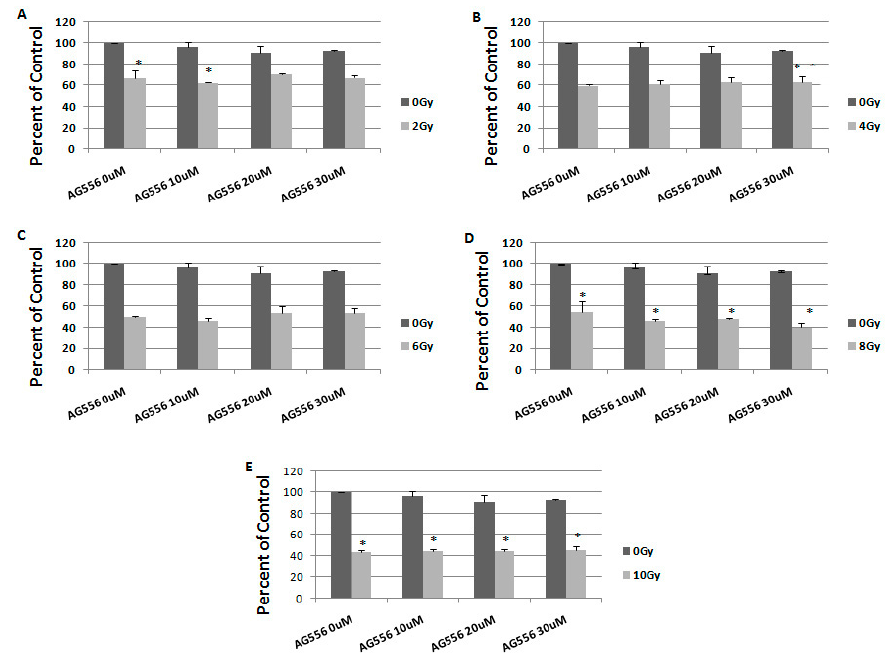
Figure 7. The effect of EGFR inhibition on ionizing radiation response in 11 HGG cells, seven days after the treatment. The cells were seeded in 96-well culture plates (3000 cells/well) then irradiated with 2 Gy ( A ); 4 Gy ( B ); 6 Gy ( C ); 8 Gy ( D ); 10 Gy ( E ) and treated with 10 μ M, 20 μ M or 30 μ M AG556. The cells were incubated for seven days and cell viability was determined by MTT assay. All results show the mean of two independent experiments ± SD, * p < 0.05 vs. irradiated cells. The cytotoxic effect of 4 Gy gamma radiation was decreased by 2% with 10 μ M AG556 treatment, by 4% with 20 μ M AG556 treatment and by 4% with 30 μ M AG556 treatment, seven days